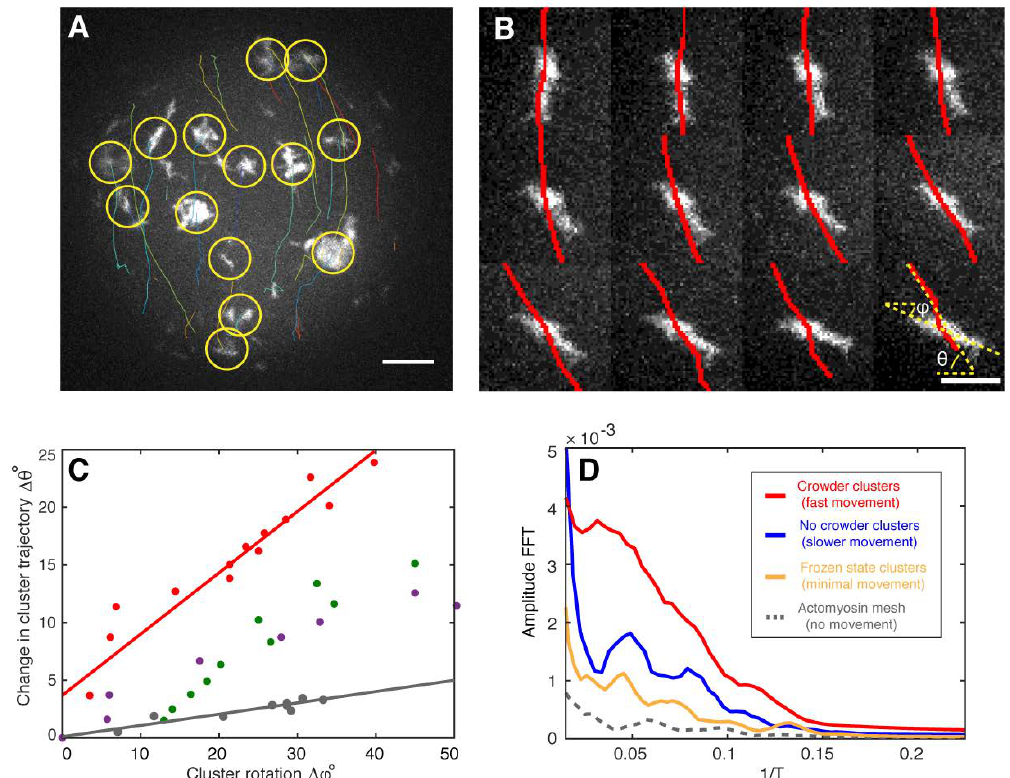
Figure 4. Fingerprints of actomyosin cluster vibrations during their directed movements. ( A ) A maximum intensity projection of confocal images of a half sphere during cortical actomyosin cluster movements is shown. Tracked actin clusters are marked by circles (yellow) and their trajectories shown (various colors, Movie S6). ( B ) Changes in the angle trajectory (red lines, θ ) agree with cluster rotations along its center of mass ( ϕ ) (left, Movie S7). Scale bar, 4 µm. ( C ) Analysis of four independent clusters (various colors) suggest that rotation influences cluster steering and then a change in trajectory ( ∆θ ). The red data points correspond to the montage shown in (B). ( D ) The fast Fourier transformation (FFT) indicates the presence of vibrational states for moving actomyosin clusters (red, blue, and yellow) different from static systems and acquisition artifacts (grey). The higher amplitude for the crowder condition with the highest cluster velocities of all measured systems implies that larger amplitudes correlate with higher velocities. Scale bar, 10 µm.